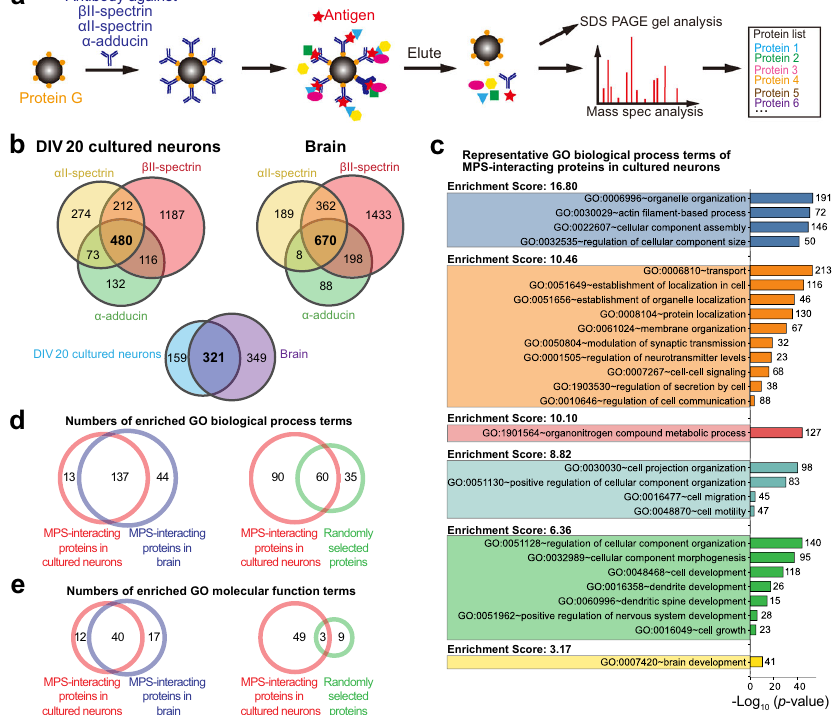
Fig. 1 Proteomic analysis and GO term enrichment analysis of candidate MPS-interacting proteins. a Schematic for co-immunoprecipitation (co-IP)- based mass spectrometry identi fi cation of candidate MPS-interacting proteins. The antibody against a bait protein, β II-spectrin, α II-spectrin, or α -adducin, was attached to protein-G-coated beads. The antibody-coated beads were then used to capture the bait protein and the co-immunoprecipitated proteins from the cultured hippocampal neuron lysate or adult mouse whole-brain lysate. The co-immunoprecipitated proteins were identi fi ed using mass spectrometry. b Top: Venn diagrams showing the overlap of the identi fi ed proteins in three co-IP experiments using β II-spectrin, α II-spectrin or α -adducin as the bait, either from cultured hippocampal neuron (DIV 20) lysates (left) or from mouse whole-brain lysates (right). Two biological replicates were performed for each co-IP condition. Bottom: Venn diagram showing the overlap between the 480 identi fi ed proteins from cultured hippocampal neurons and the 670 identi fi ed proteins from mouse whole-brain lysates (See Supplementary Data 1 for the full list of the candidate MPS-interacting proteins). c Functional annotation clustering of the enriched Gene Ontology (GO) terms in the biological process (BP) category for the 480 candidate MPS- interacting proteins identi fi ed in cultured hippocampal neurons. A selected subset of GO BP terms are shown (See Supplementary Data 2 for the full list of clustered GO BP terms enriched in the candidate MPS-interacting proteins). The corresponding p -values (bars) and protein numbers (next to the bars) for each enriched GO BP term are shown on the right. d Venn diagrams showing the overlap between the enriched GO BP terms of the 480 candidate MPS- interacting proteins identi fi ed in cultured mouse hippocampal neurons (DIV 20) and the enriched GO BP terms of the 670 candidate MPS-interacting proteins identi fi ed in the adult mouse whole brain (left). Also shown in comparison is the overlap between the enriched GO BP terms of the 480 candidate MPS-interacting proteins in cultured mouse hippocampal neurons (DIV 20) and the enriched GO BP terms of 670 randomly selected genes from the mouse genome (right). e Same as d but for GO MF terms instead of GO BP